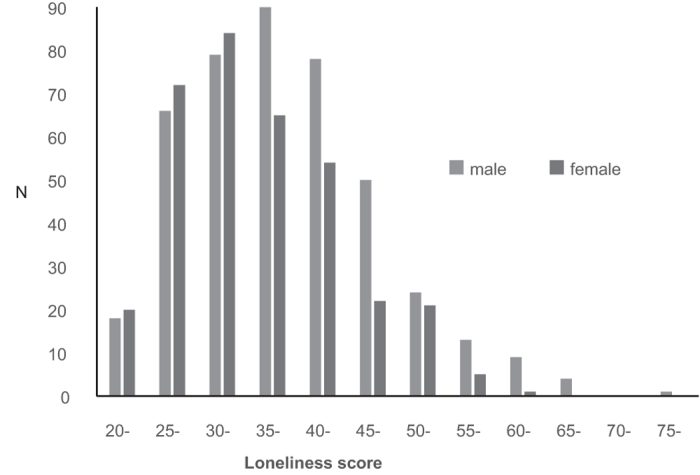
Distribution of Loneliness Scale scores in males and females.Histogram showing the distribution of loneliness scores for all subjects.